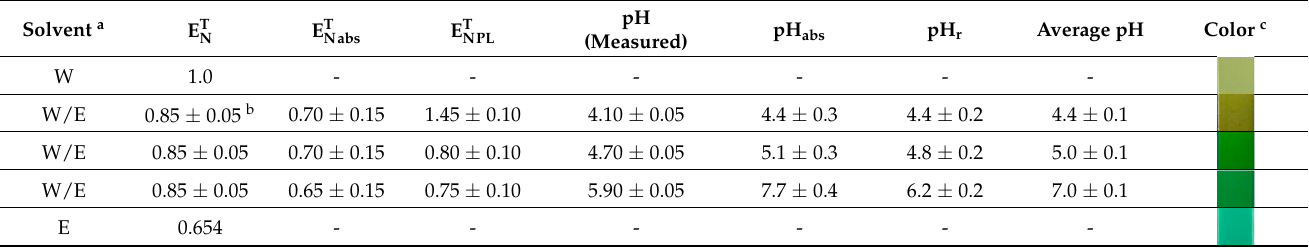
Table 1. Measured and estimated values for CD-w samples in different media.